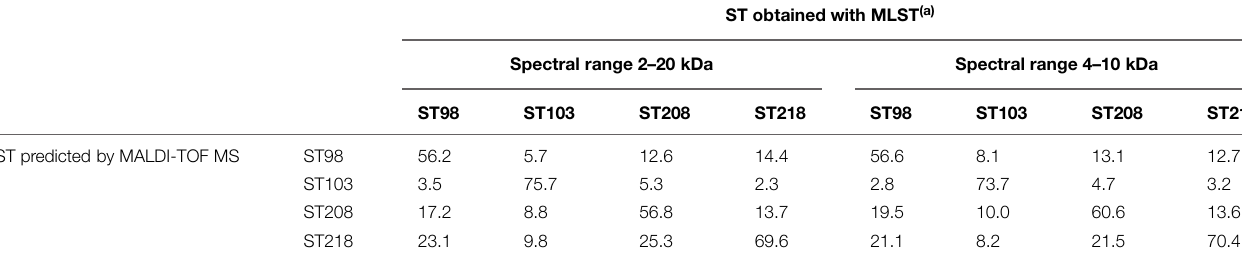
ST obtained with MLST